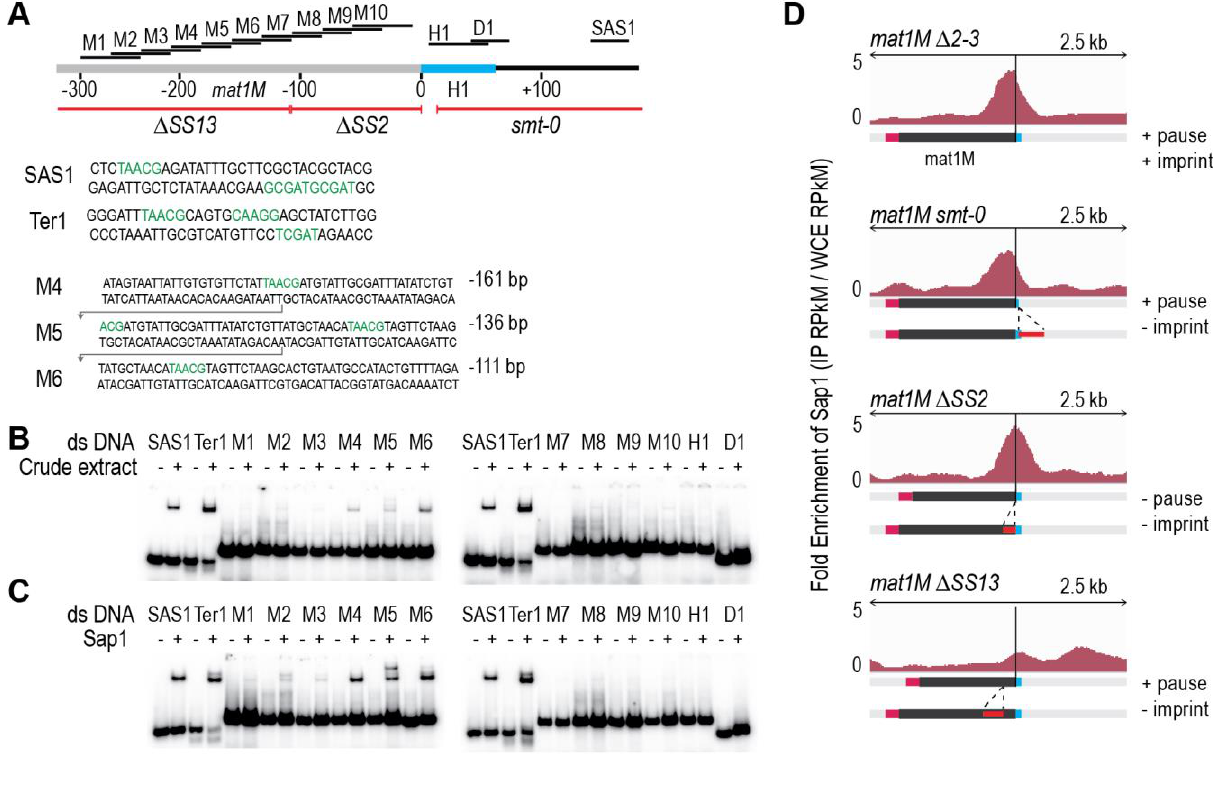
FIGURE 5: Sap1 is recruited in mat1M . (A) Schematic view of right region of the mat1M locus. The probes used for the shift assay as well as the sites of the deletion strains used for the ChIP-seq of Sap1 are indicated. The sequence of the probes that trigger a shift in B and C are indicated. (B) Electrophoretic mobility shift analysis (EMSA) of crude extracts from S. pombe . SAS1 and Ter1 are used as controls. In lanes (-), 1 ng of radio labelled dsDNA is used with no proteins. In lanes (+), 5 µg of total proteins and 1 ng of radio labelled ds DNA are used. (C) EM- SA of Sap1-6xHis protein purified from E. coli . In lanes (-), 1 ng of radio labelled ds DNA is used with no proteins. In lanes (+), 40 ng of Sap1- 6xHis protein and 1 ng of radio labelled ds DNA are used. (D) Distribution of normalized enrichments of Sap1 ChIPs (IP RPkM / WCE RPkM) in the mat1M ∆ 2-3, mat1M smt-0 ∆ 2-3, mat1M ∆ SS2 ∆ 2-3 and mat1M ∆ SS13 ∆ 2-3 backgrounds. The sequence used for the alignment is a 10-kb region that contains the mat1M , mat1M smt-0, mat1M ∆ SS2 or mat1M ∆ SS13 , respectively . Only mat1M is shown. The MT switching phenotype of the deletion strains is